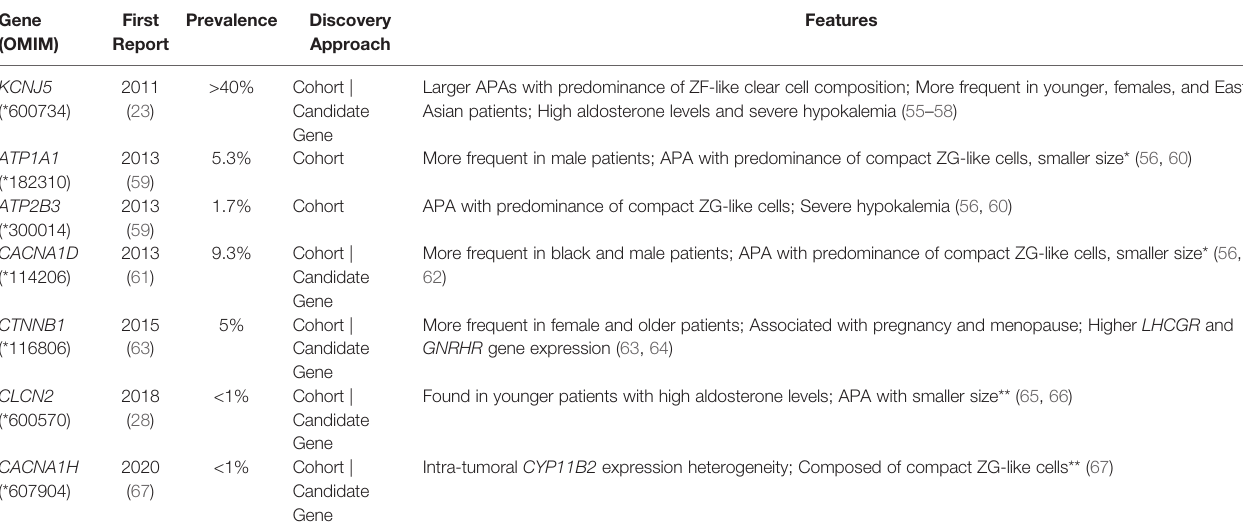
TABLE 3 | Genetic causes of unilateral primary